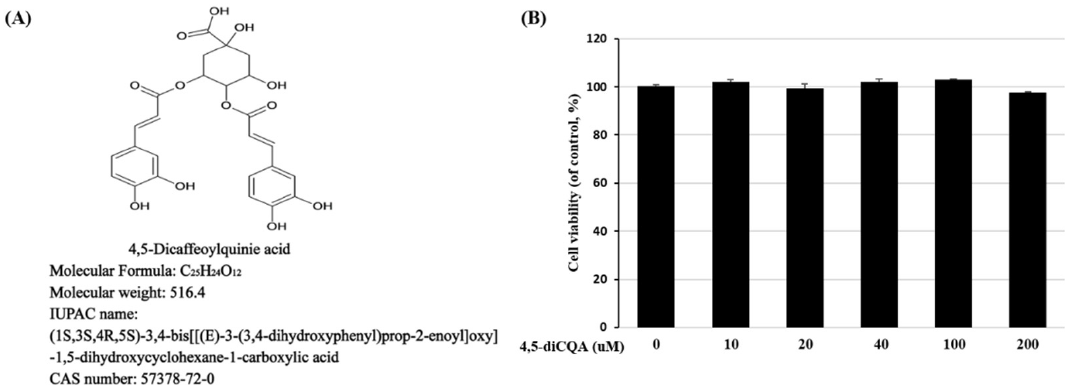
Figure 1. Effects of 4,5 − diCQA on rat primary chondrocyte viability. ( A ) Chemical formula of 4,5 − diCQA (https://pubchem.ncbi.nlm.nih.gov/compound/4_5-Di-O-caffeoylquinic-acid, accessed on 20 November 2021). ( B ) Cells were treated with 4,5-diCQA (10, 20, 40, 100, and 200 µ M) for 24 h, and viability was determined by MTT assay. Cells incubated without 4,5-diCQA were used as controls and were considered 100% viable. Data are represented as mean ± SD of three indepen- dent